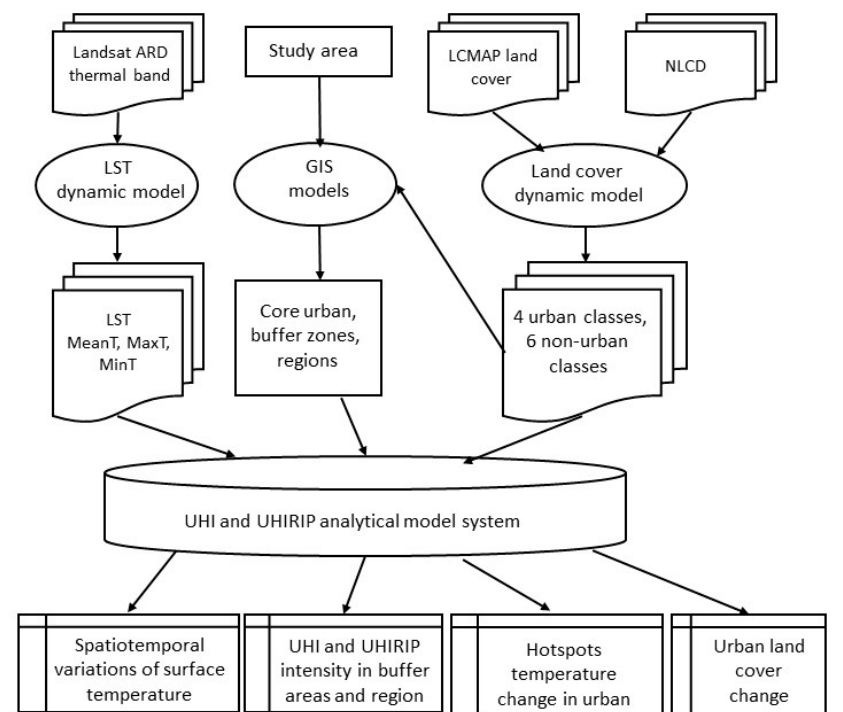
Figure 4. A general workflow chart of the use of time series of LST and land change dynamic data that provides a consistent and quantitative analysis for the distribution and change of UHI intensity and UHIRIP in Sioux Falls,